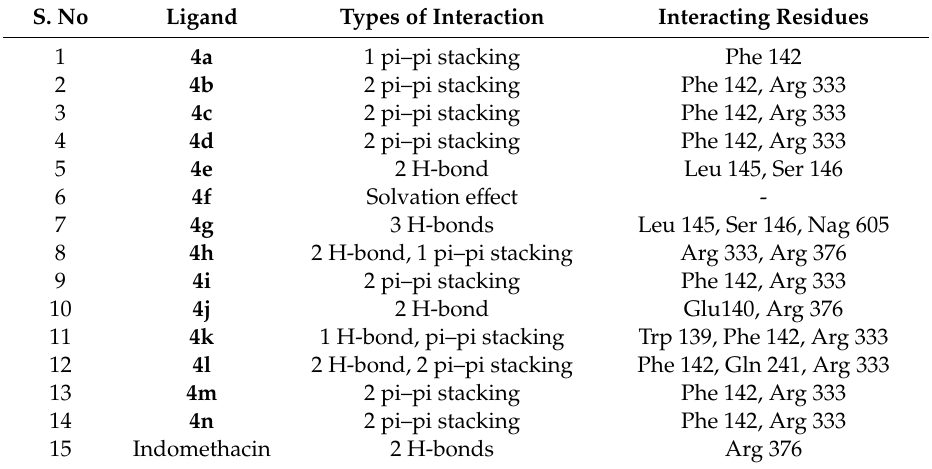
Table 7. Type of interaction and amino acid residues involved in that interaction inside the binding pocket of the Cox-2 enzyme from mouse